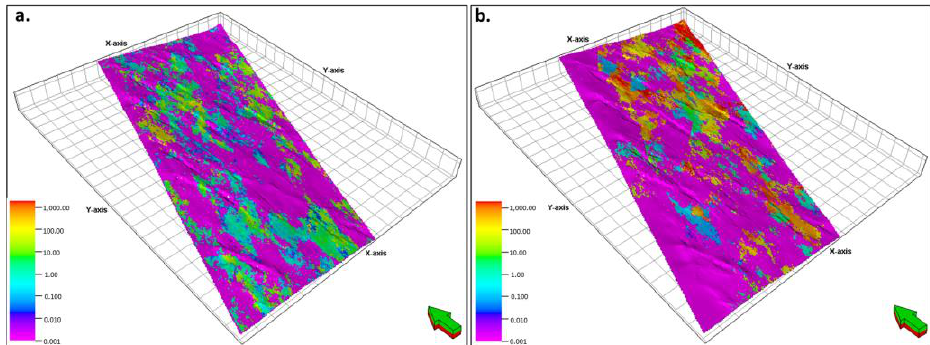
Figure 20. Porosity-permeability relations of the four rock types identified in H reservoir.